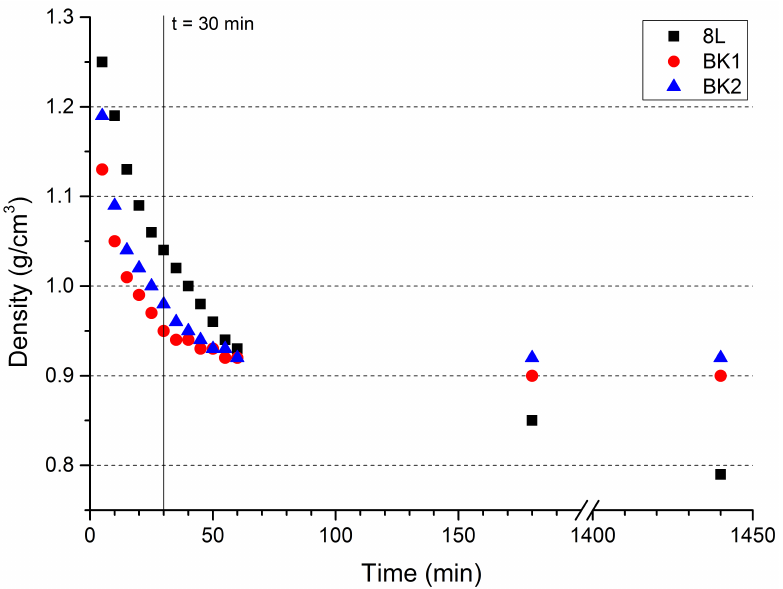
Figure 5. Comparison of changes in the density of the EE samples over